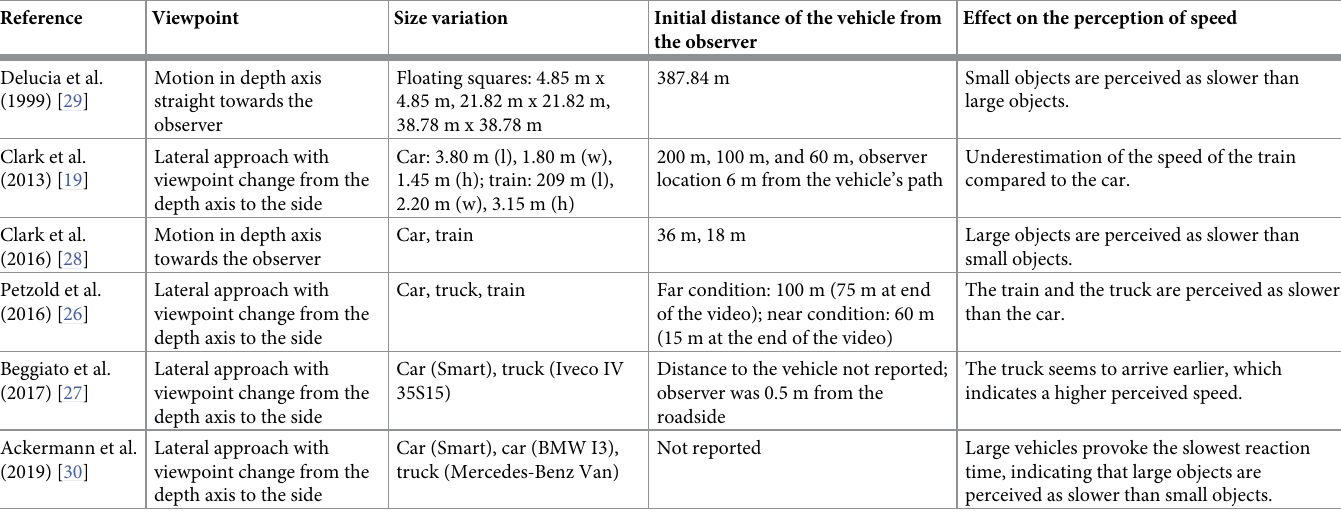
Table 1. Review in the field of size-speed effects.